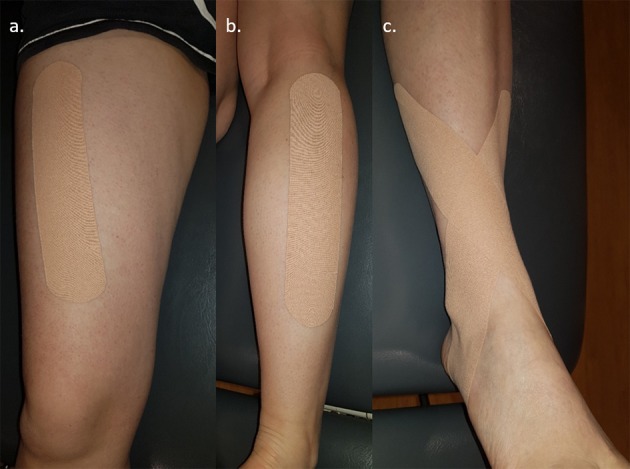
Location of tape application on dominant leg: (a) anterior thigh—rectus femoris; (b) posterior leg—gastrocnemius; (c) ankle—anti-inversion ankle strap.